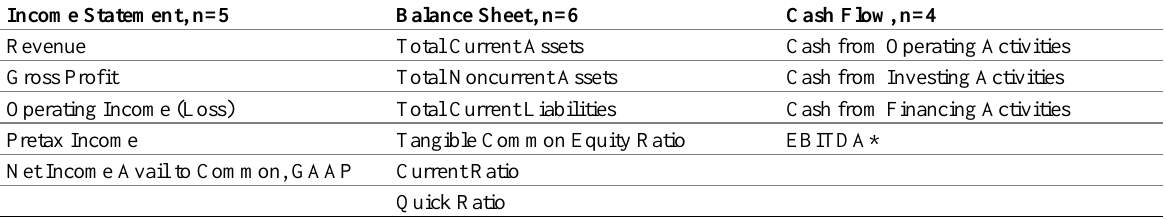
Table 2: GAAP-Sensitive Blocking Variables as Selected for Testing in the AP-Context